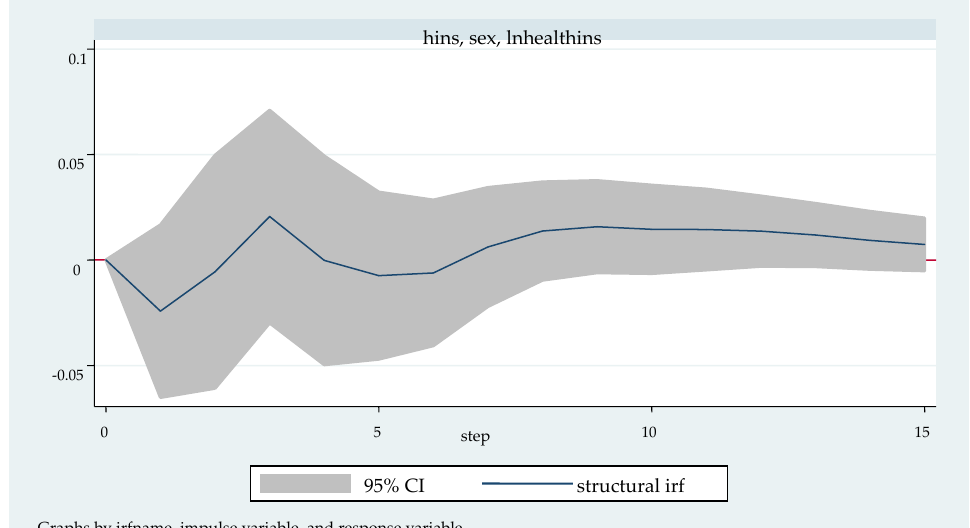
Figure 5. Impulse response function diagram of “lnhealthins” impacted by